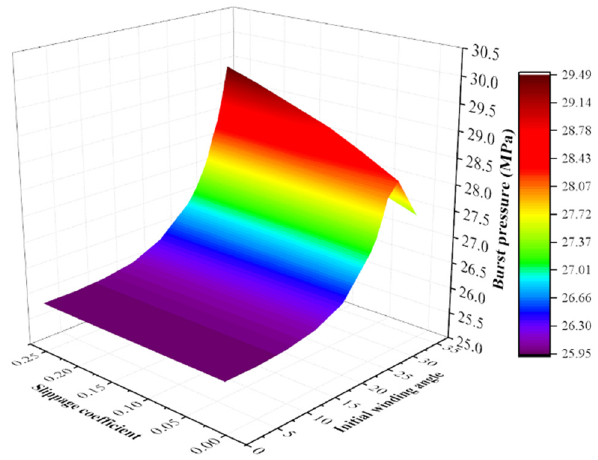
Figure 8: E ff ect of winding parameters on the burst pressure.